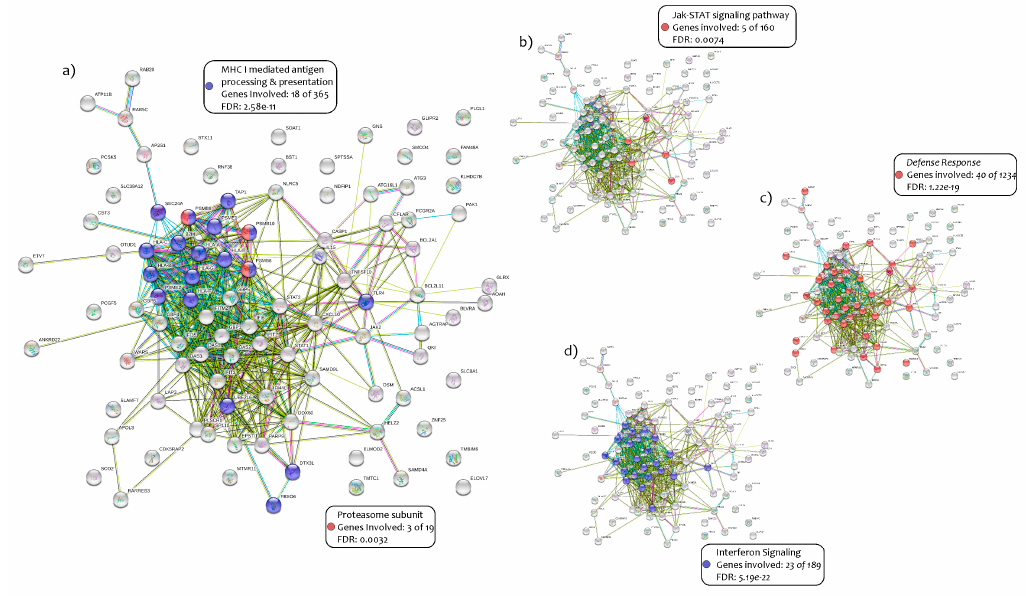
Figure 1. GO analysis in 100 genes upregulated in JAK2 V617F mutated